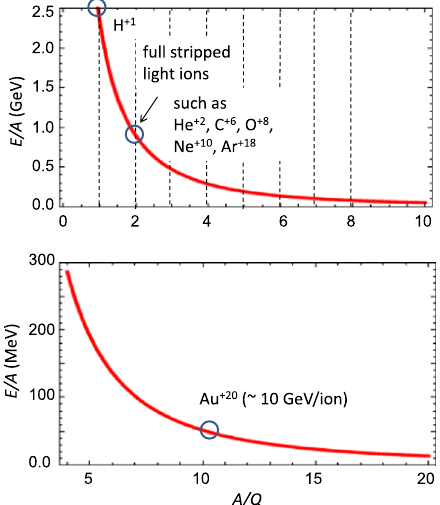
FIG. 13. Obtainable maximum energy per nucleon vs A=Q